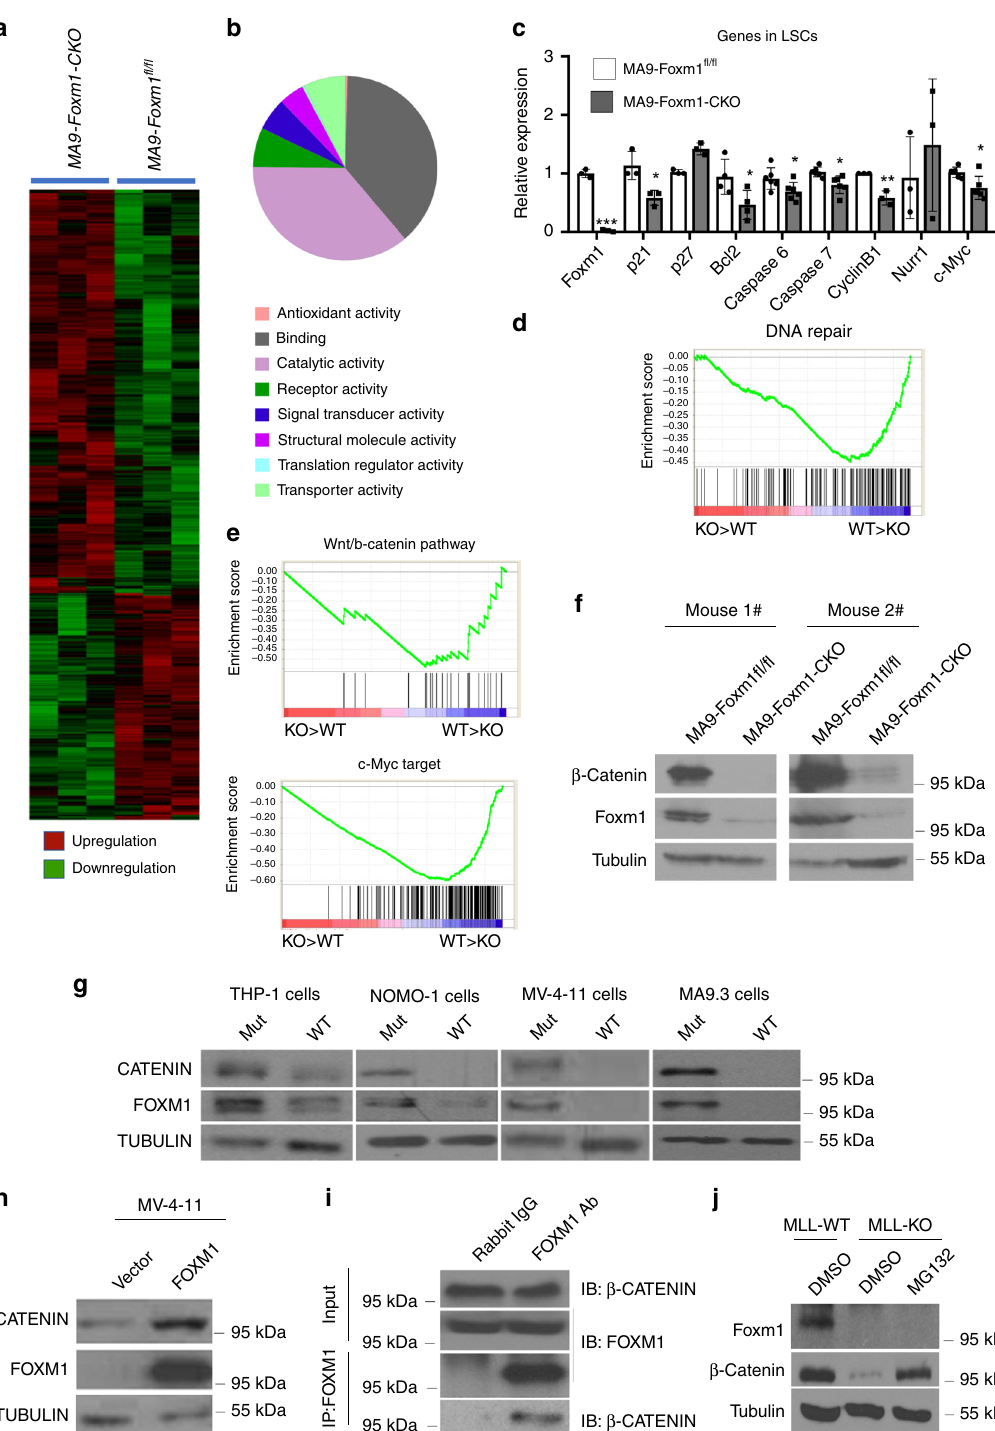
cells but not in wildtype hematopoietic stem/progenitor cells Foxm1 stabilized β -catenin protein by inhibiting polyubiquitina- tion of β -catenin, thereby preventing its degradation by protea- somes. This indicates a cell-context-dependent role of Foxm1 in regulation of β -catenin stability. To determine whether Foxm1- mediated stabilization of β -catenin is dependent on its binding ability to β -catenin instead of its transcriptional activity, we gen- erated two Foxm1 mutants including Foxm1 Δ Cat with a deletion of β -catenin binding domain and Foxm1DNAMut containing mutated DNA binding domain according to the